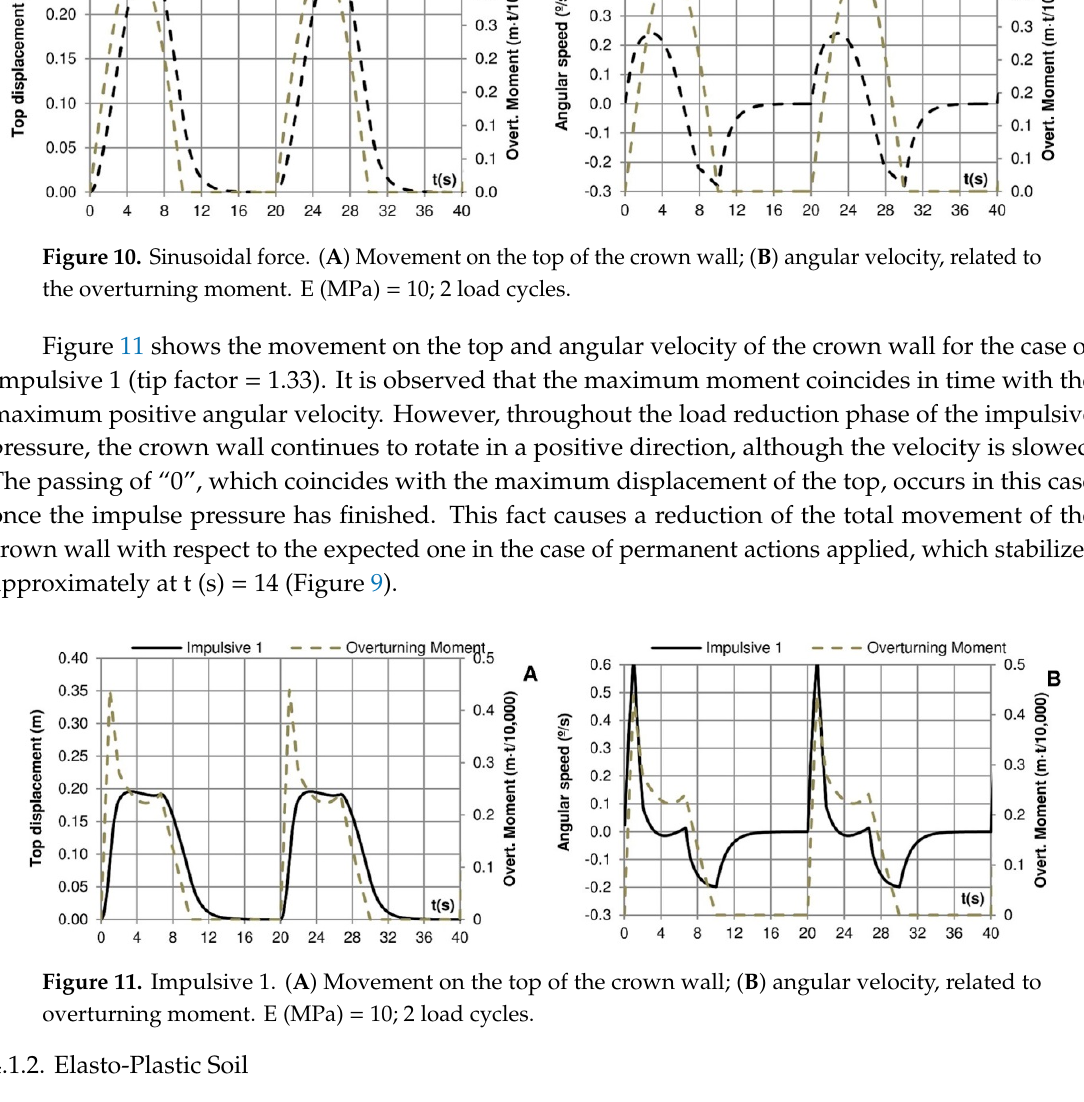
Figure 12. ( A ) Movement on the top of the crown wall; ( B ) maximum vertical deformation of the foundation. The estimated deformations in the foundation are again far from those considered inadmissible (See Table A2 in Appendix B). In the case of this model of soil, a residual deformation of the foundation between 0.24% and 0.64% occurs as a function of the load signal, as a consequence of the nonlinearity of the stress and deformation (Figure 13).